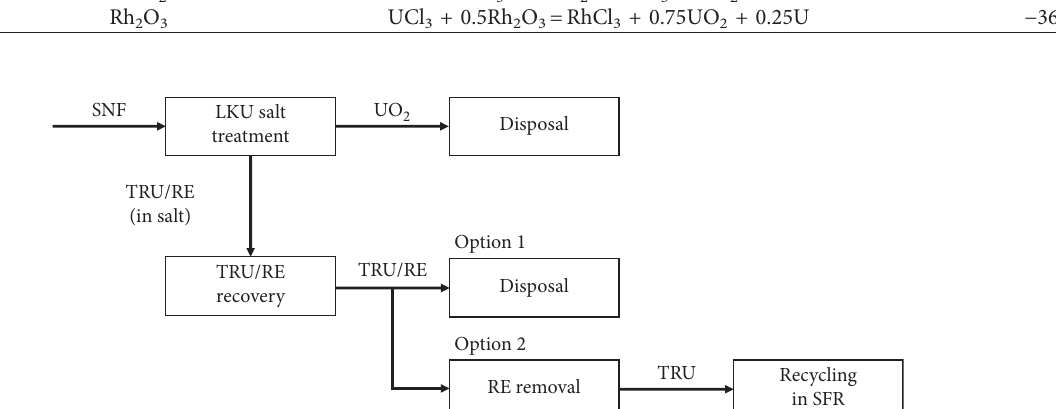
Figure 2: Flowchart of the back-end fuel cycle processes with the LKU salt treatment technique in a case when TRUs are separated from the